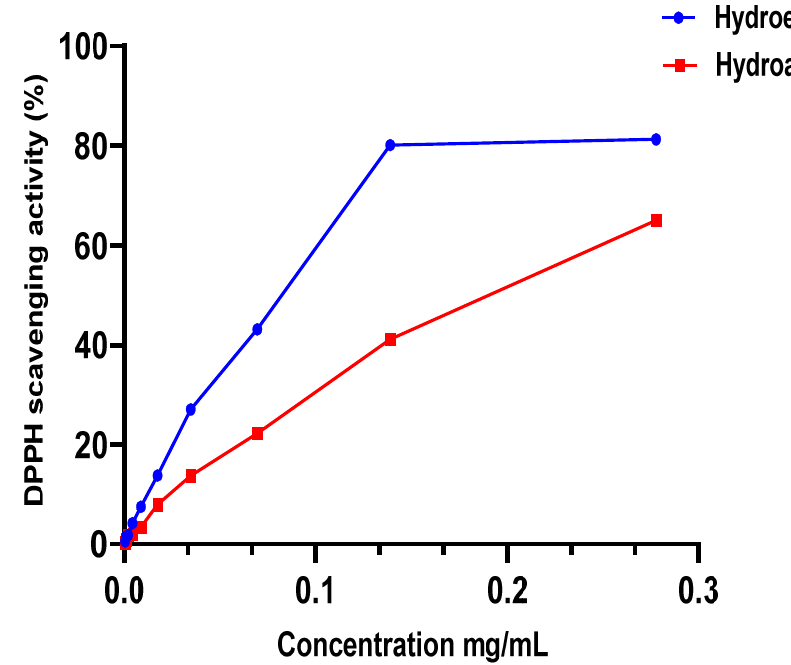
Figure 2. DPPH scavenging activity of extracts.